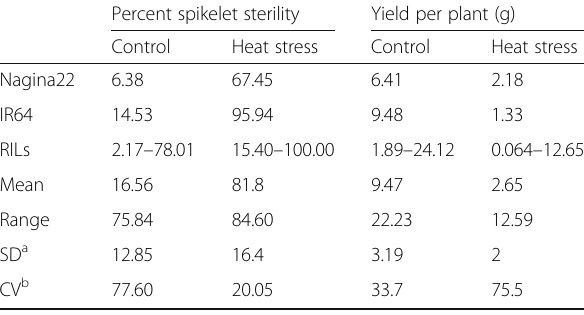
Table 1 Performance of the parents and their recombinant inbred lines under control and heat stress Percent spikelet